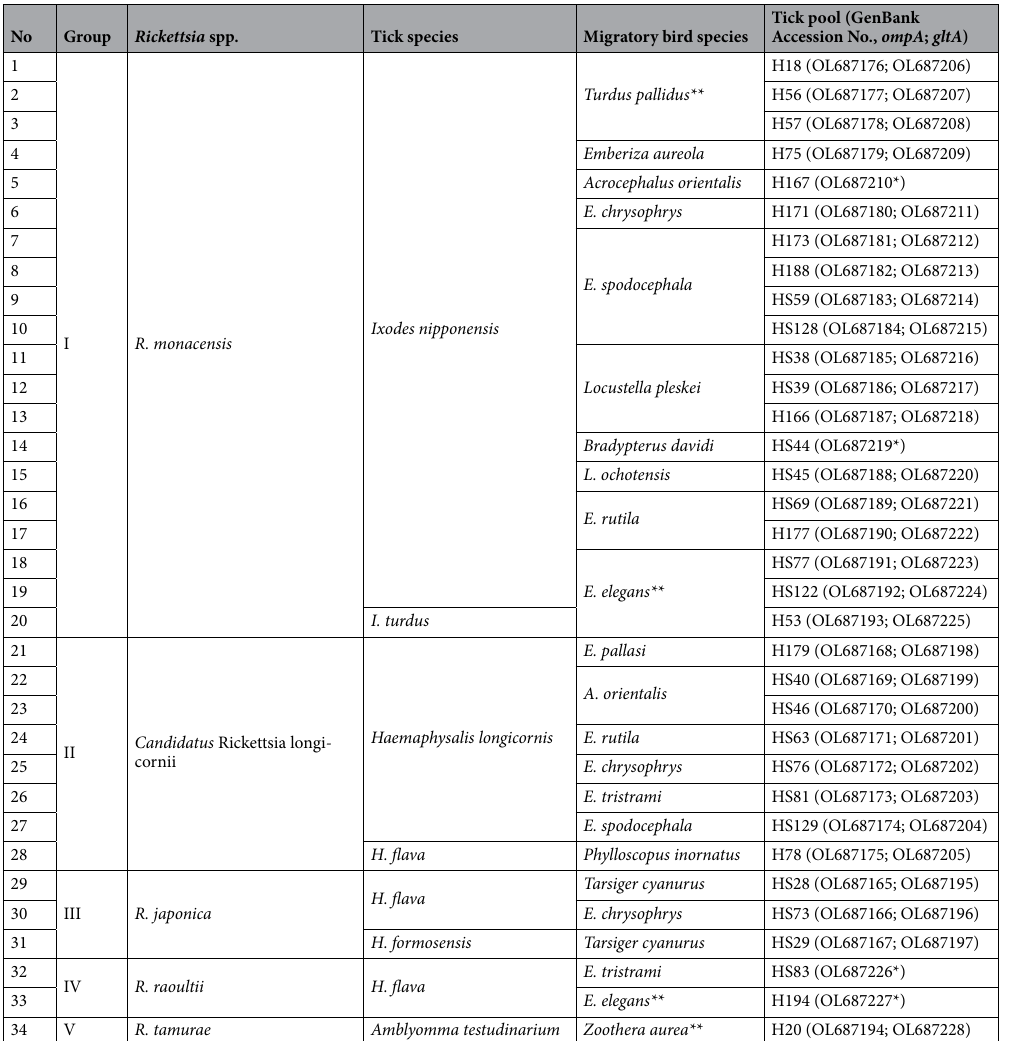
Various tick-borne microorganisms ( Rickettsia spp., Borrelia spp., Anaplasma spp., B. grahamii , and T. gondii ) were detected in ticks collected from migratory birds in the ROK, of which Rickettsia spp. were the most abundant group 20–22 . However, infections of these pathogens in related bird species has not been characterized in the ROK. There are stopover habitats in the ROK for migratory birds on their migration routes between the northeastern Palearctic region, including Russia and eastern China, and southeast Asia 21 . The presence of tick-borne pathogens ( B. garinii , A. phagocytophilum , and E. chaffeensis ) in migratory birds was confirmed in China 35 . These results suggest that the migratory birds collected in the ROK may be infected and become important natural reservoirs of these tick-borne pathogens. Therefore, it is necessary to conduct further studies on the surveillance of tick- borne pathogens in migratory and resident birds and local tick and animal/bird reservoirs to better understand the role of migratory birds in the potential introduction and spread of tick-borne pathogens. Wild birds are known to be reservoir hosts of C. burnetii and F. tularensis and associated ticks might transmit the pathogens to human 36,37 . Ixodes ricinus infesting birds were suggested to be the vectors of C. burnetii 37,38 . In the ROK, C. burnetii and F. tularensis were detected more frequently in H. longicornis and H. flava ticks col- lected from the environmental habitats and domestic or wild animals 39–41 . However, the two pathogens were not detected in ticks infesting wild birds in this study, and the presence of these two pathogens in ticks feeding on birds in China and other southeast Asian countries located along their migration routes 21 has not been recorded. Surveillance of C. burnetii , F. tularensis, Rickettsia spp., and T. gondii in this study demonstrated the presence of T. gondii in ticks collected from migratory birds. Rickettsia spp., including R. monacensis, Ca. R. longicornii , R. japonica, R. raoultii , and R. tamurae , were the most commonly detected microorganisms in ticks collected